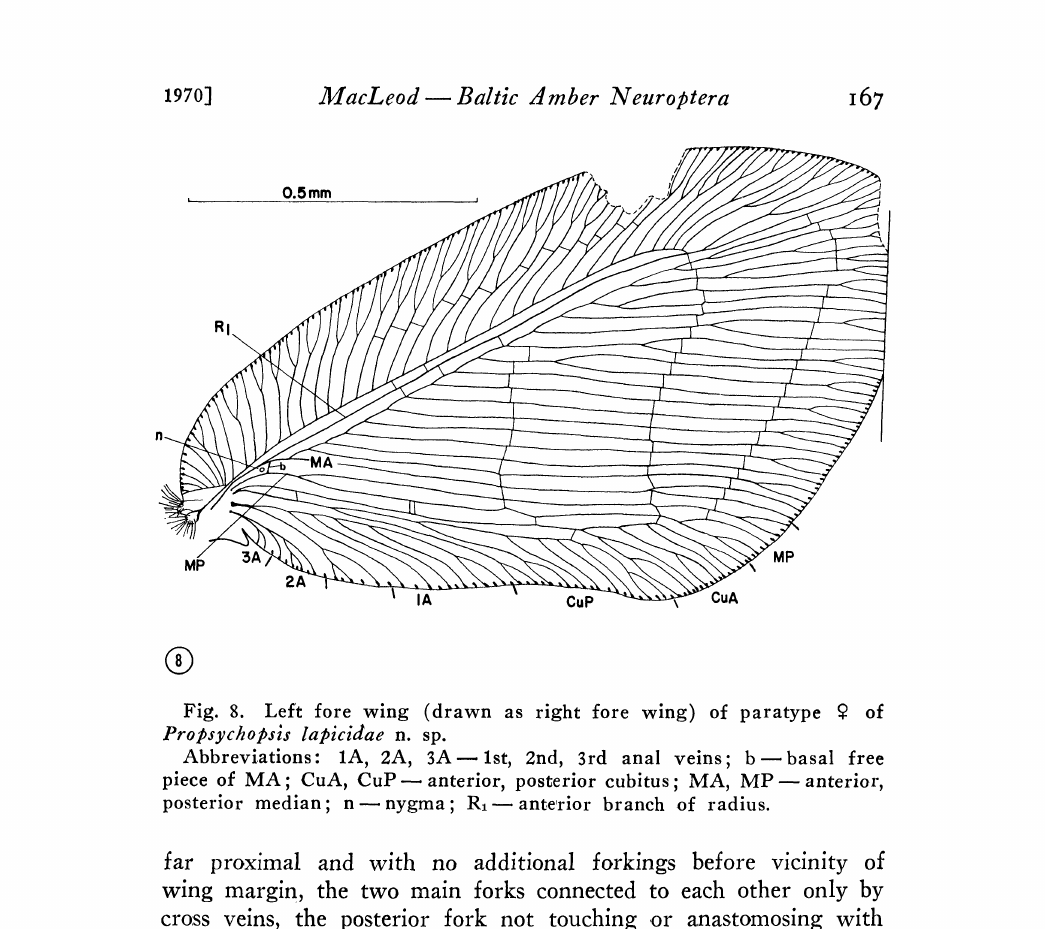
Fig. 8. Left fore wing (drawn as right fore wing) of paratype of Propsychopsls lapicidae n.